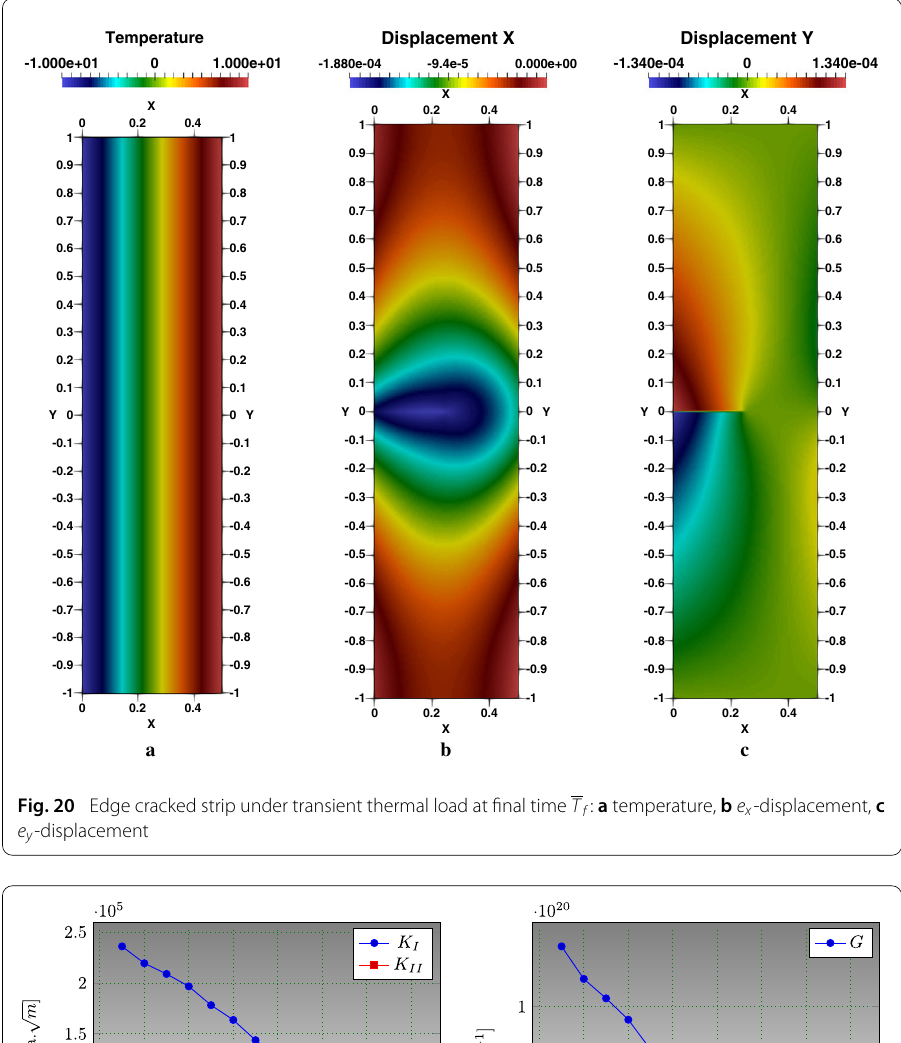
Fig. 20 Edge cracked strip under transient thermal load at final time T f : a temperature, b e x -displacement, c e